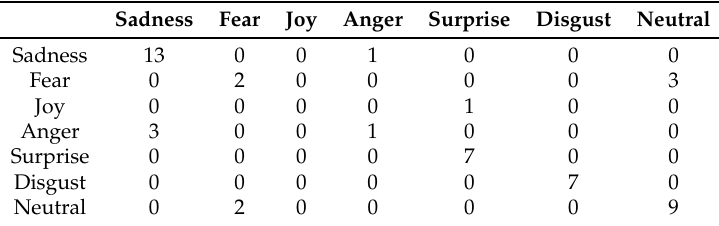
Table A18. A1 actor confusion matrix from the Emo-DB in the third phase.